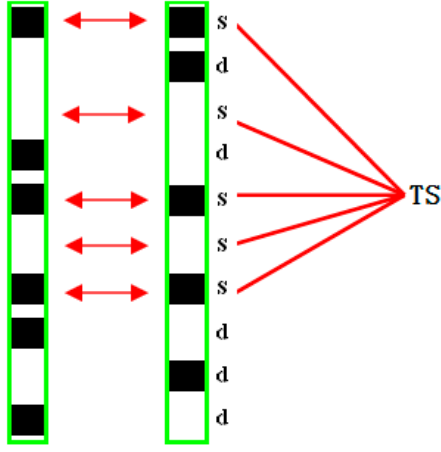
Figure 23. Total number of the same types of blocks between two shreds.